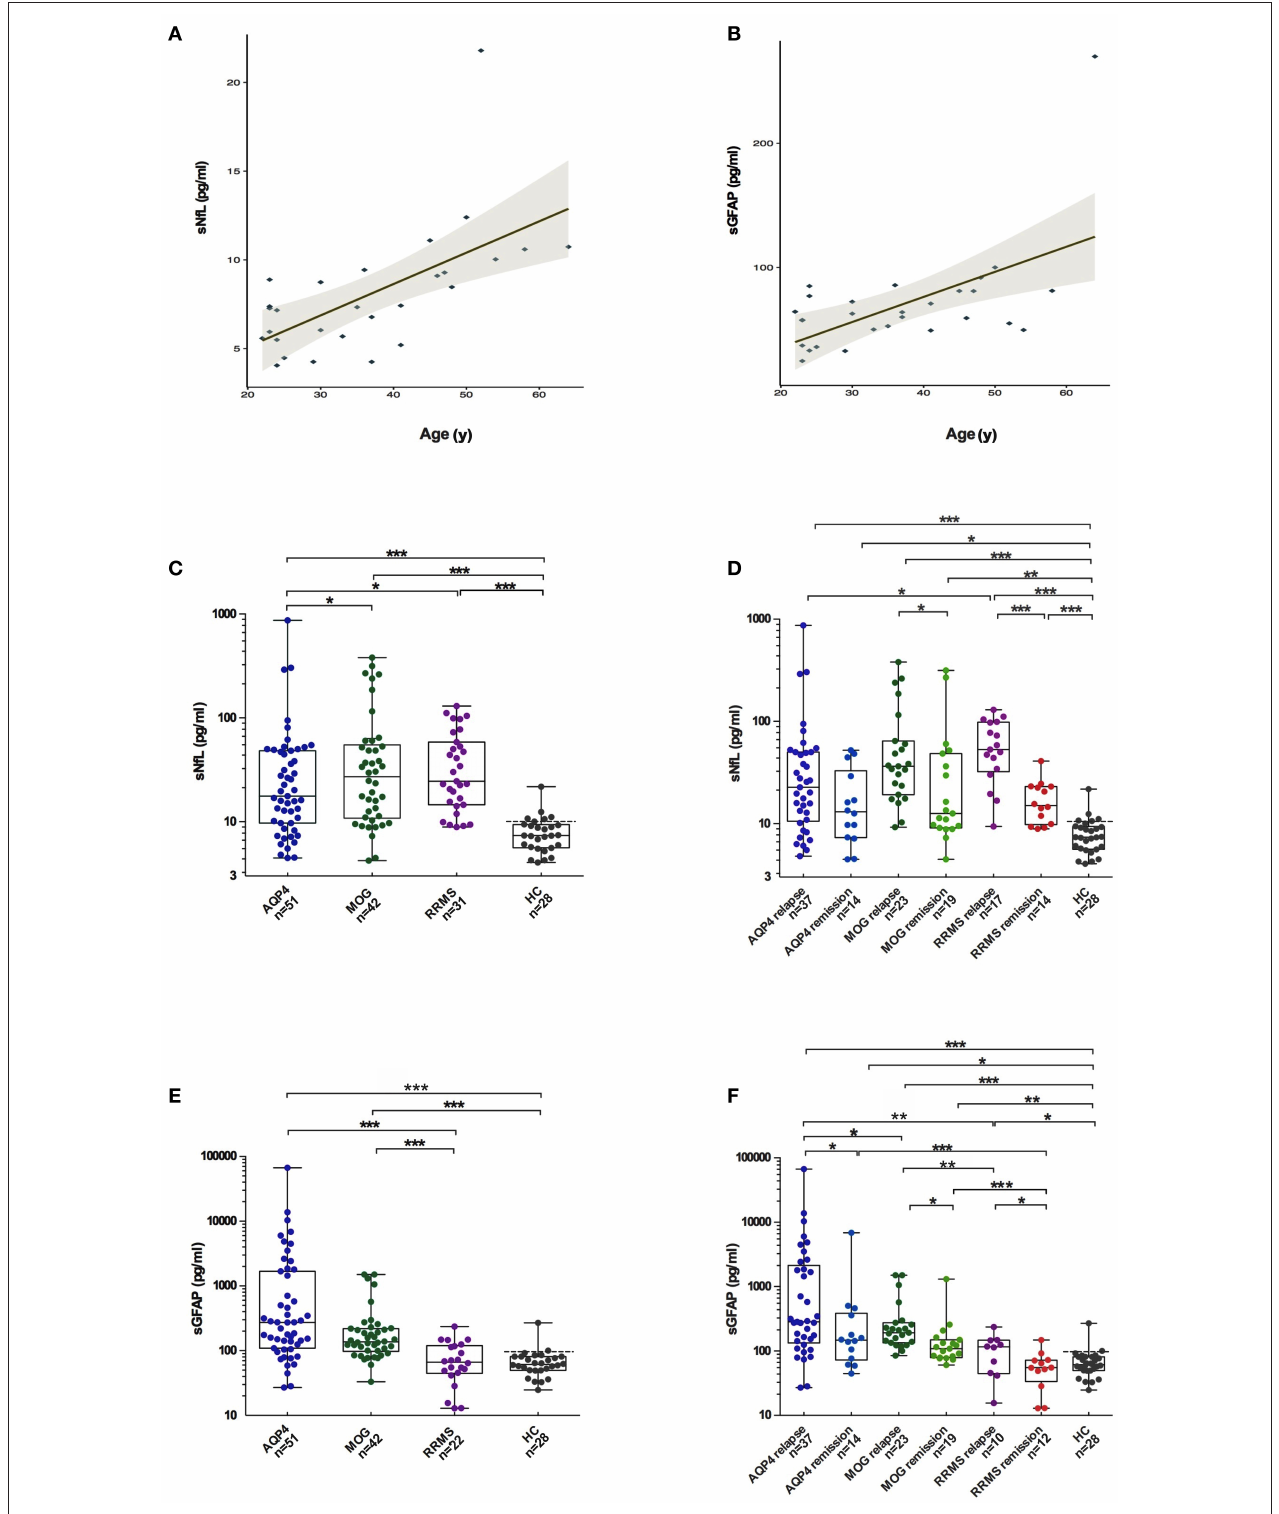
FIGURE 1 | Comparisons of sGFAP and sNfL levels among the different groups. (A,B) Correlations of sNfL and sGFAP levels with age in HCs. (C,E) sNfL and sGFAP levels were compared among all the samples from patients with AQP4-antibody-positive NMOSD, MOGAD, and RRMS, as well as from HCs. (D,F) Samples from the three disease groups were divided into relapse and remission stages and were compared. Boxes depict the median and interquartile range (IQR), with the median